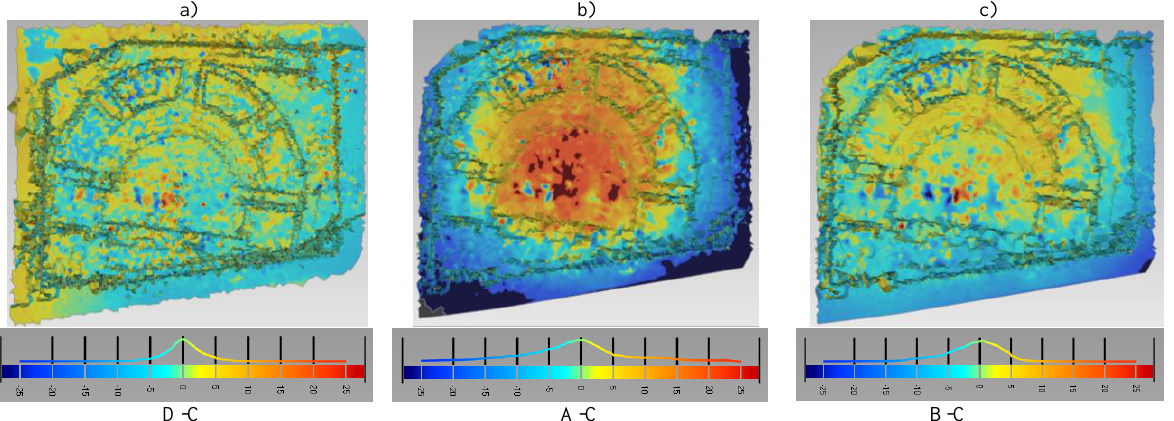
Fig. 4: Euclidean distances [mm] between meshes triangulated over 3D coordinates of tie points obtained with different bundle adjustment computations and network configurations (named version A, B, C and